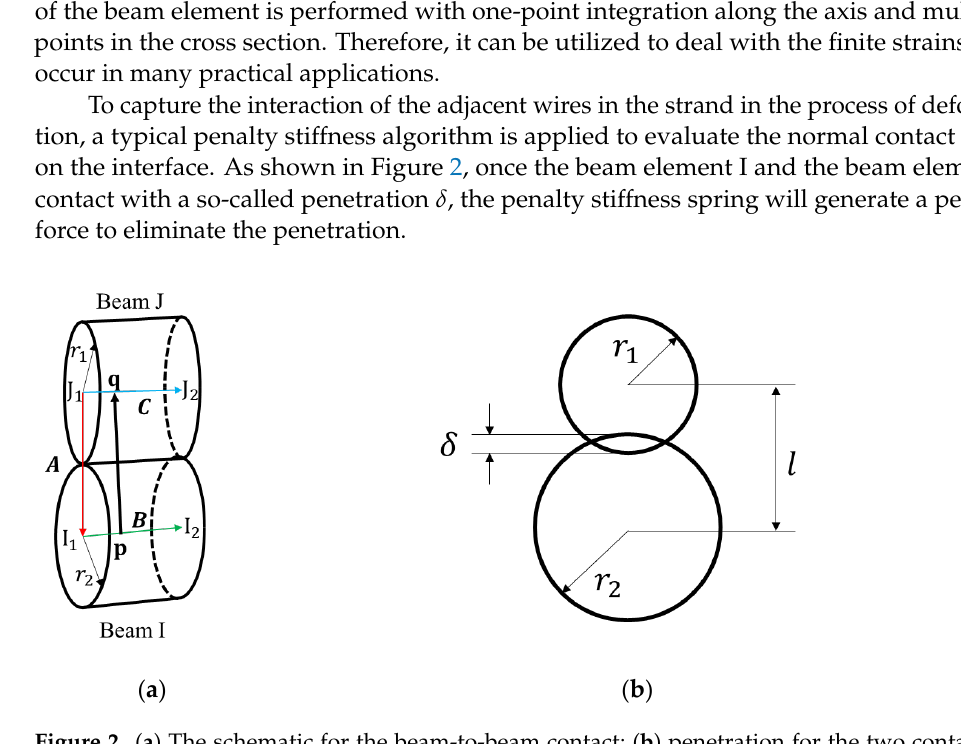
Figure 2 . ( a ) The schematic for the beam-to-beam contact; ( b ) penetration for the two contacting beam elements in a cross-section view.